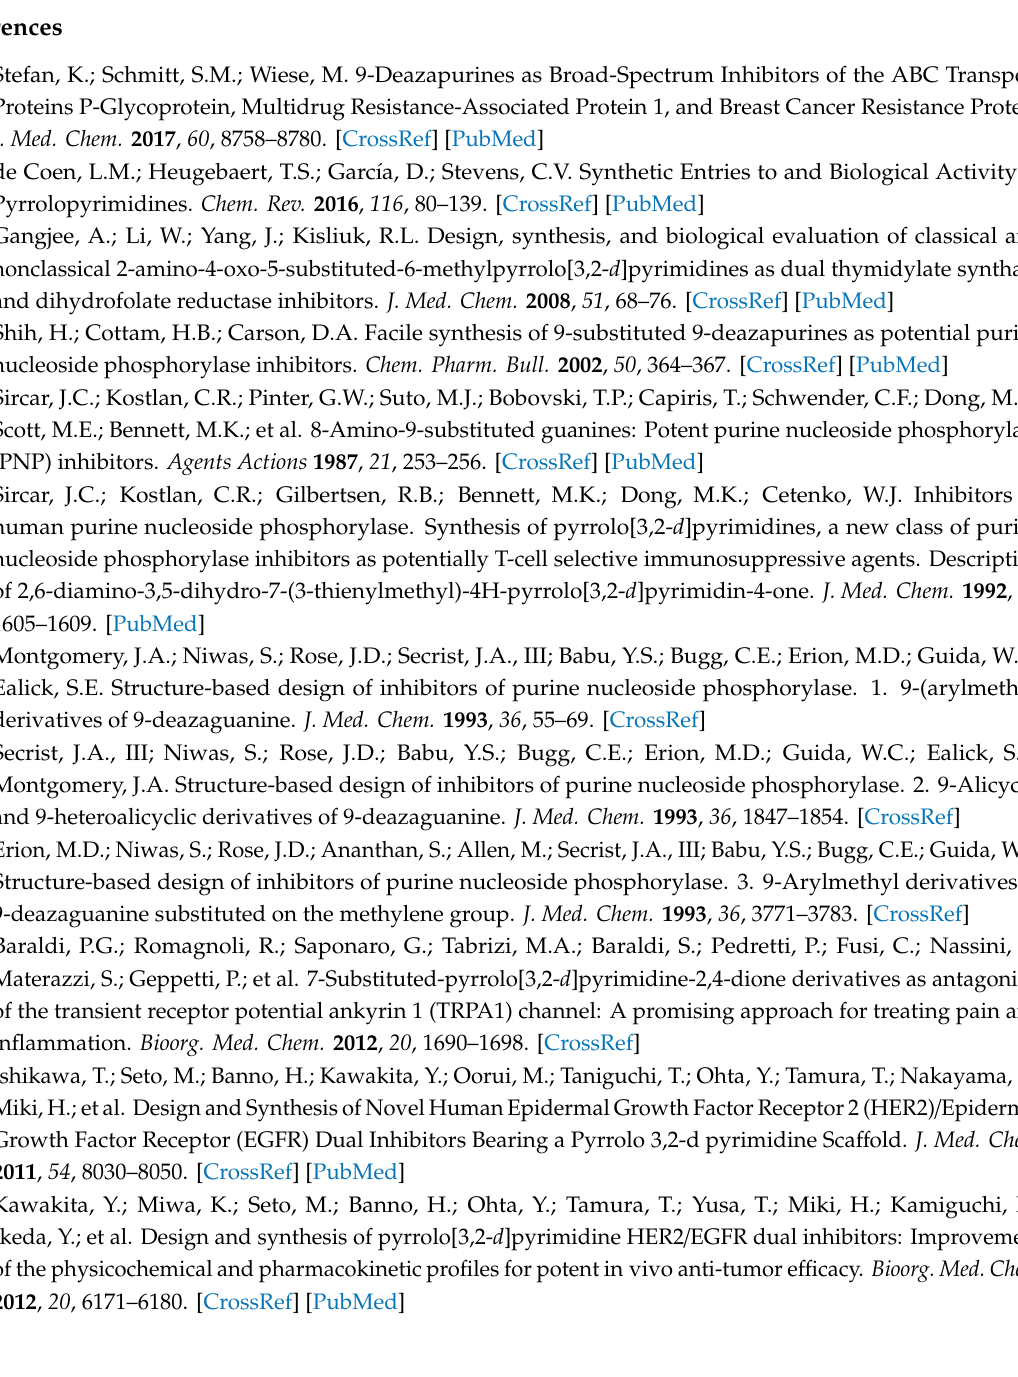
Figure S2: 1 H-NMR of Compounds 6 – 15 , Figure S3: 13 C-NMR of Compounds 6 –